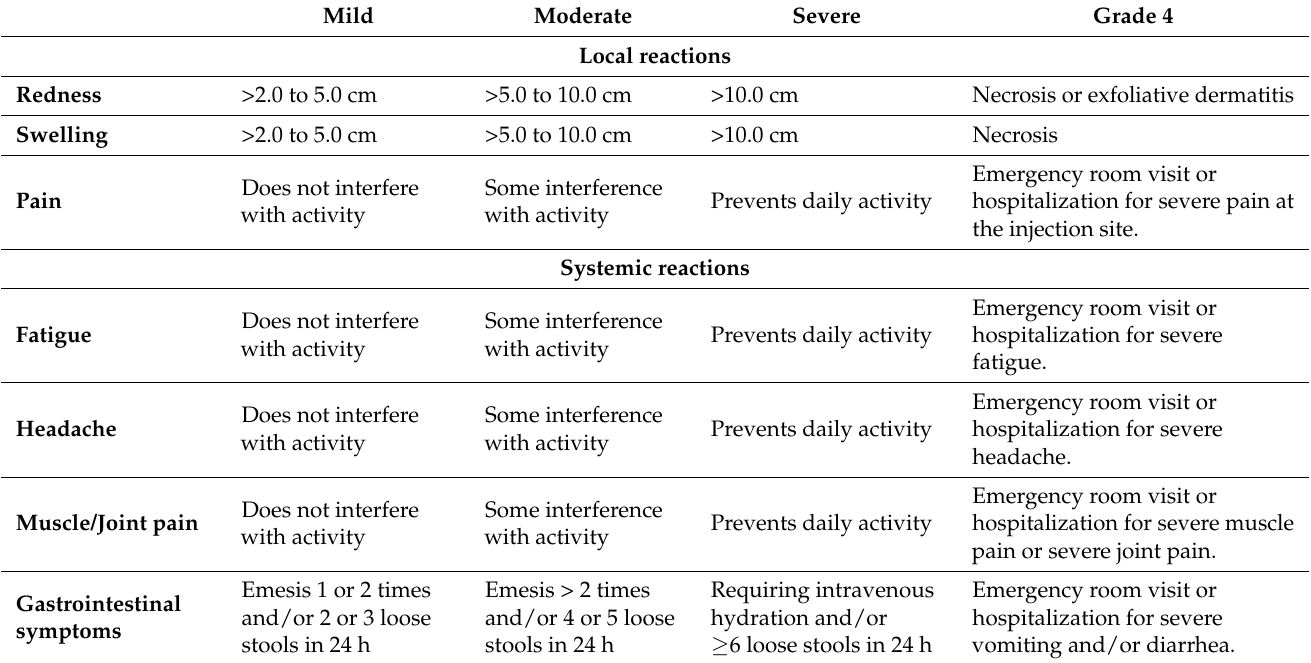
Table 1. Classification of local and systemic adverse reaction severity following